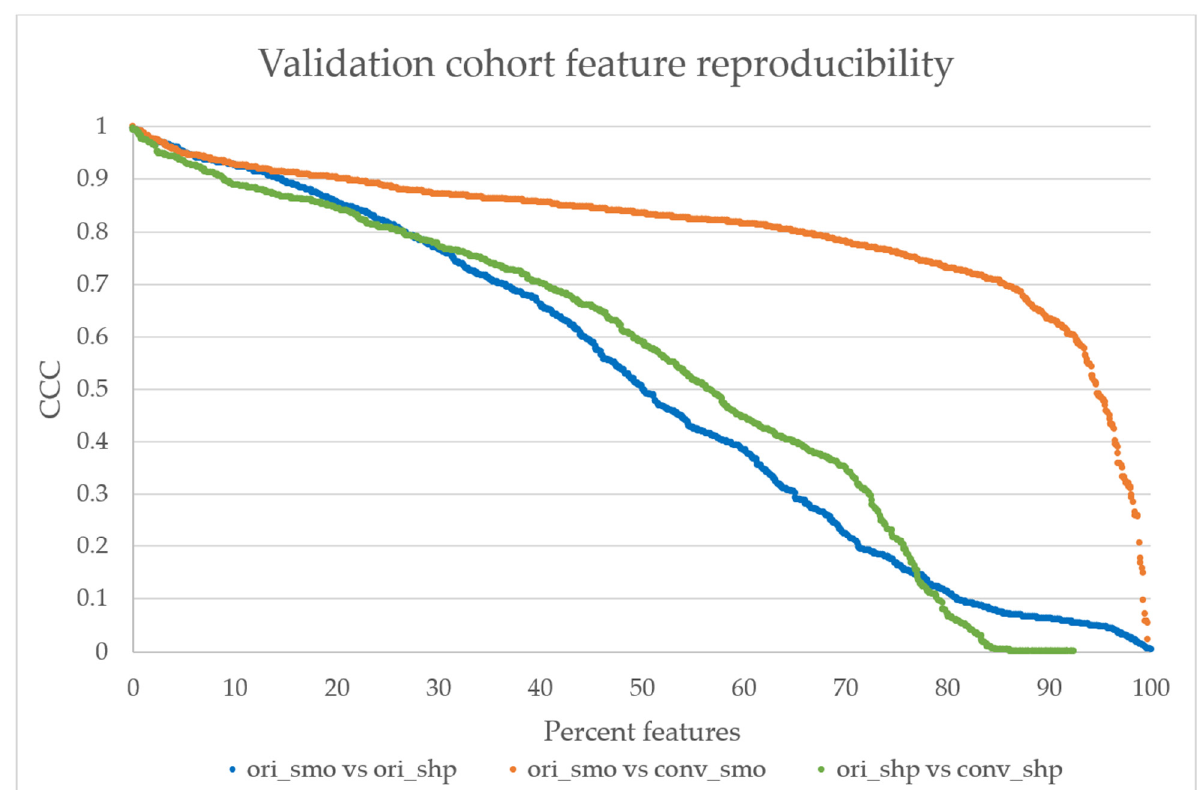
Figure 4. The validation cohort’s reproducibility graph. The reproducibility of features calculated from original smooth and sharp kernels show that only 20% of the features have CCC > 0.85 (highly reproducible) [21]. After the kernel conversion to smooth, more than 40% of features show CCC > 0.85, while only 20% of features from the sharp comparison show CCC > 0.85. The distributions between ori_smo vs. ori_shp and ori_smo vs. conv_smo are significantly different with p < 0.001, but the distributions are not significantly different between ori_smo vs. ori_shp and ori_shp vs. conv_shp. Table 3. Validation cohort’s average and median reproducibility values calculated in CCC. The Wilcoxon matched-pairs signed ranks test results are shown for (ori_smo vs. ori_shp) group against (ori_smo vs. conv_smo) group and (ori_smo vs. ori_shp) group against (ori_shp vs. conv_shp) group. Ori_smo vs. Ori_shp